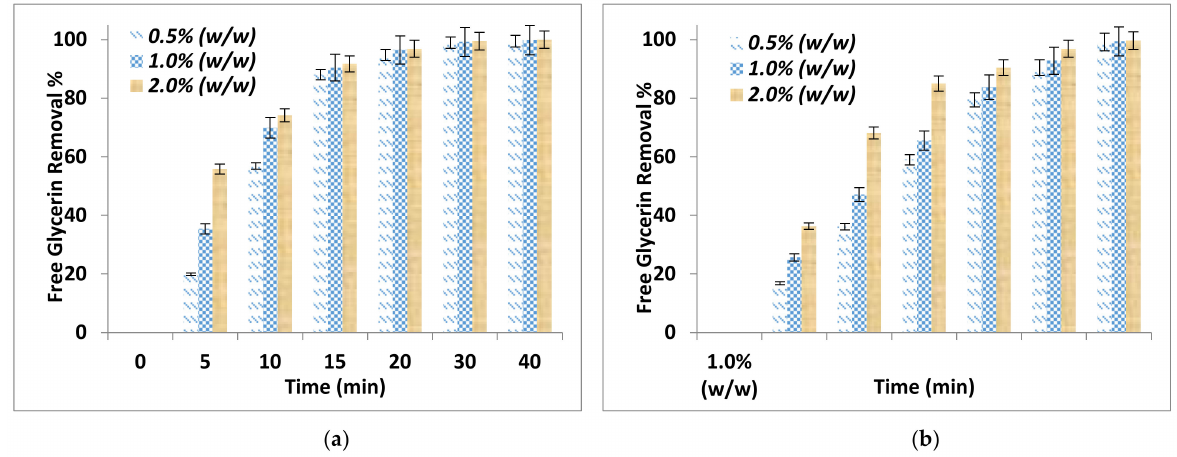
Figure 2. Effect of adsorption time on free glycerin removal for different adsorbent dosage ( a ) Particle sizes ≤ 90 µ m ( b ) Particle size of ≤ 150 µ